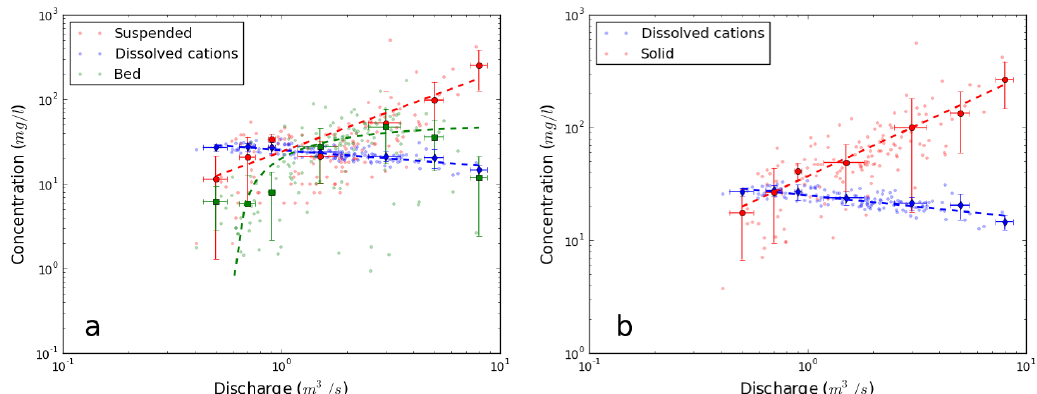
Fig. 11. Weathering and erosion: (a) correlation between the concentration and discharge for the weathering load, suspended load and bedload. (b) Correlation between chemical weathering concentrations and total solid concentrations versus discharge in the Urumqi River. Small points represent individual measurements, squares represent binned averages and dashed lines correspond to fitted trends.